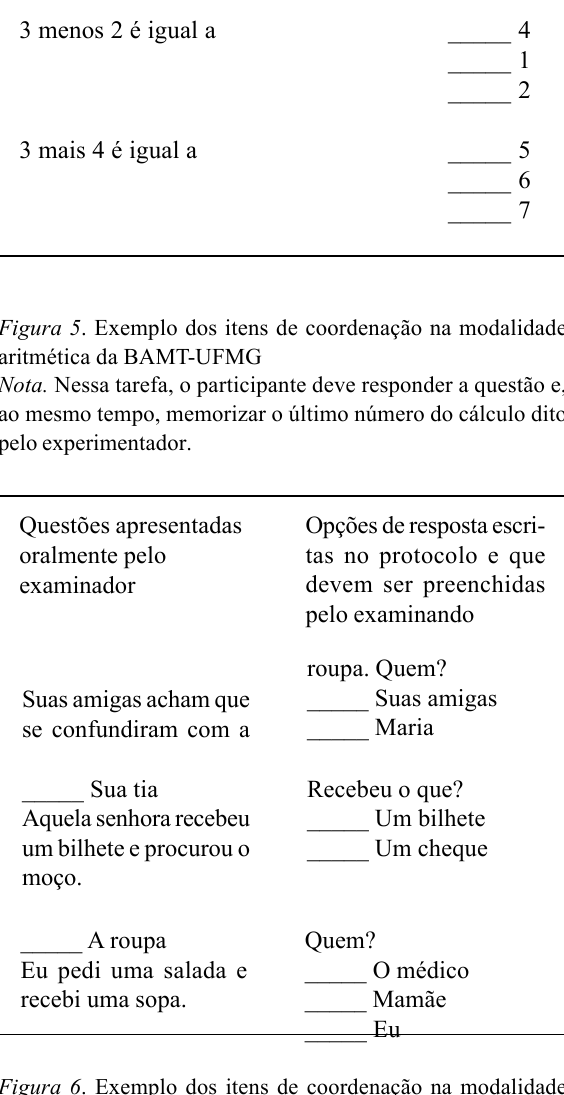
Figura 6 . Exemplo dos itens de coordenação na modalidade verbal da BAMT-UFMG Nota. Nessa tarefa, o participante deve responder a questão e, ao mesmo tempo, memorizar a última palavra dita pelo experimentador, ao realizar a